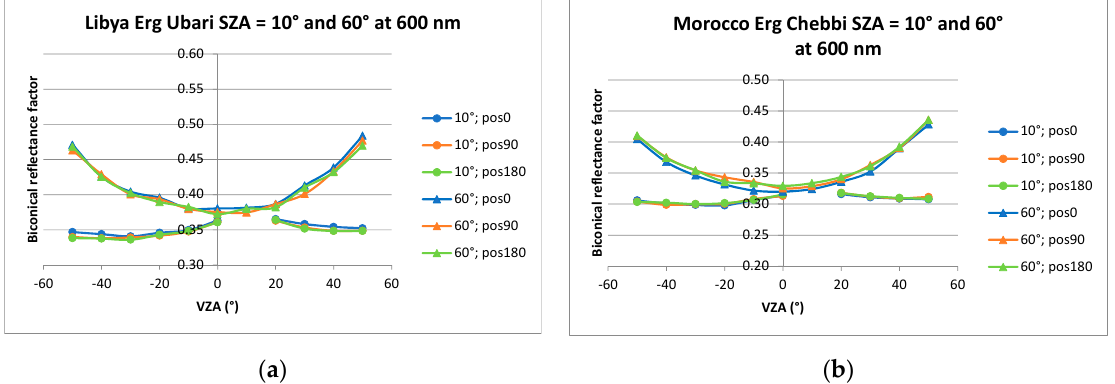
Figure 13. BCRF for the minimum (10°) and the maximum (60°) solar zenith angles, in the principal plane, for: ( a ) Libya; ( b ) Morocco.